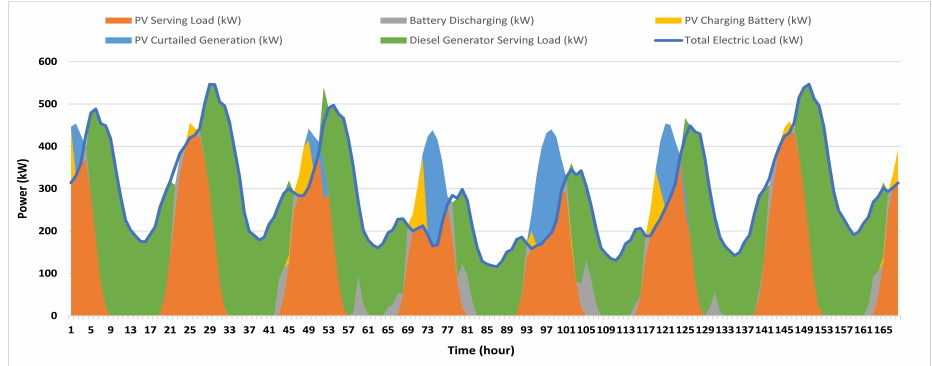
Figure 14. Microgrid operation during a week in the rainy season: Case